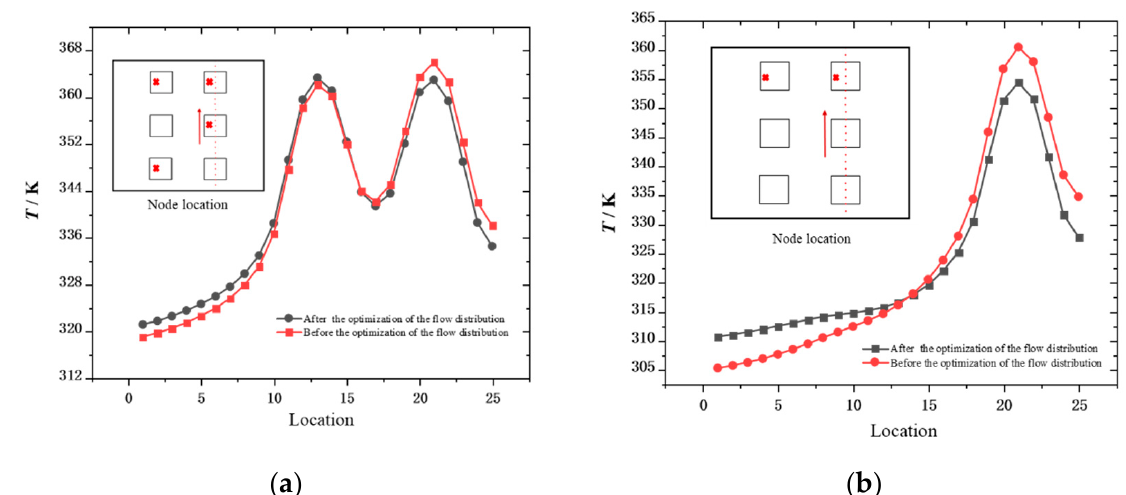
Figure 11. Changes in temperature at lateral nodes of the chip before and after flow optimization: ( a ) case 1; ( b ) case 3.